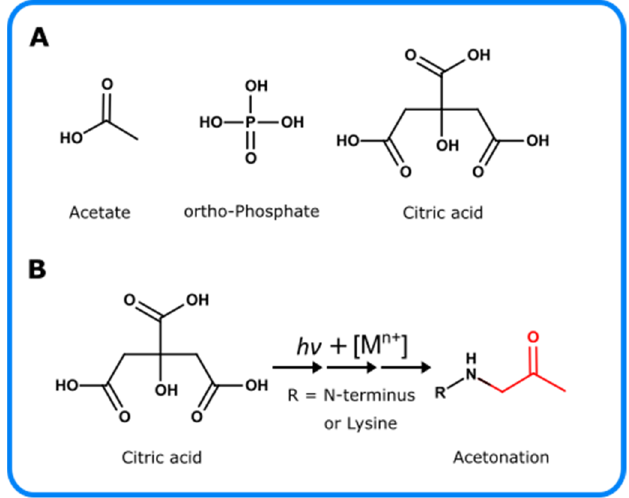
Figure 8. Buffer molecules and their involvement in photo-oxidation. ( A ) Chemical structures of common buffer molecules used in therapeutic protein formulations. ( B ) Light and metal ion dependent modification of proteins by citric acid via primary amine acetonation.